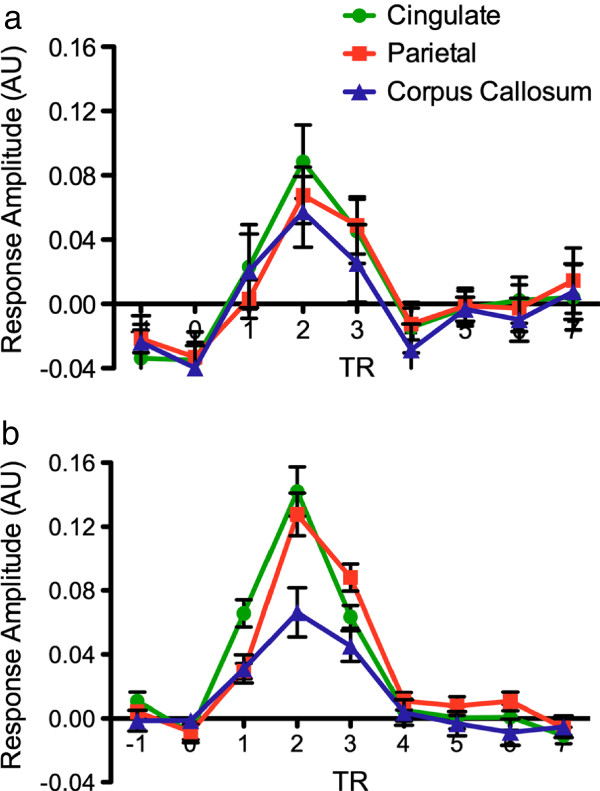
(a) Hemodynamic response function (HRF) data (arbitrary units; AU) for the raw isolates (n = 8 averaged). The horizontal axis depicts time in TRs (2 second repetition time). Data were extracted from ROIs in the corpus callosum, cingulate, and parietal areas. (b) HRF data (AU) for the finite impulse response analysis from all three ROIs. All other details as per Figure
3a.